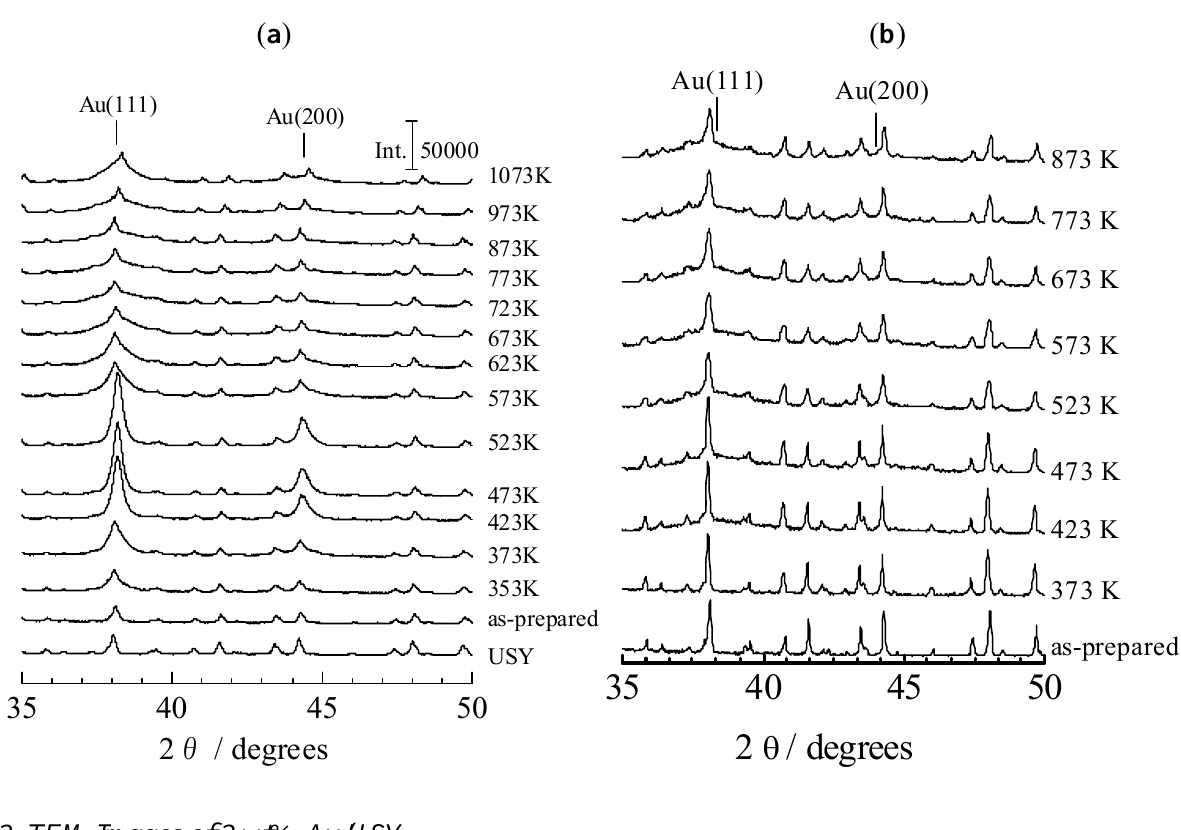
Figure 2. ( a ) XRD patterns of Au/USY zeolites treated at different temperatures under a 6% H 2 atmosphere diluted with Ar. Data was collected under ex situ conditions. Samples were stored in the dark for more than one month; ( b ) XRD patterns of Au/USY treated at different temperatures under a 3% H 2 atmosphere diluted with Ar. Data was collected under in situ